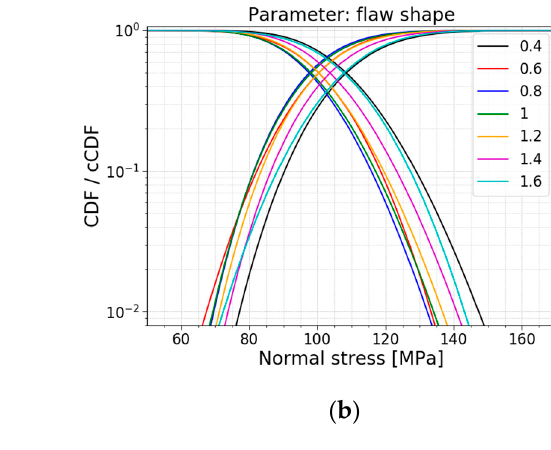
Figure 23. ( a ) PDF and ( b ) CDF for a varying flaw shape.